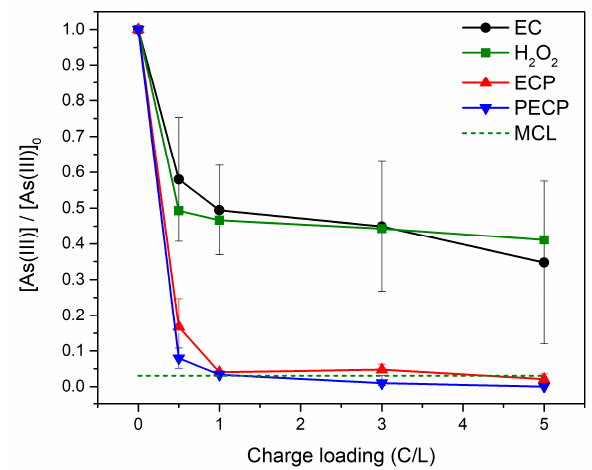
Figure 3. As(III) concentration profile using di ff erent treatment processes: ( • ) electrocoagulation, ( (cid:4) ) oxidation using H 2 O 2 , ( (cid:78) ) electrochemical peroxidation, ( (cid:72) ) photo-assisted electrochemical peroxidation (initial As(III) = 331 ± 21 µ g / L; initial pH = 7; charge dosage rate = 1 C / L / min; H 2 O 2 concentration = 5 mg / L).